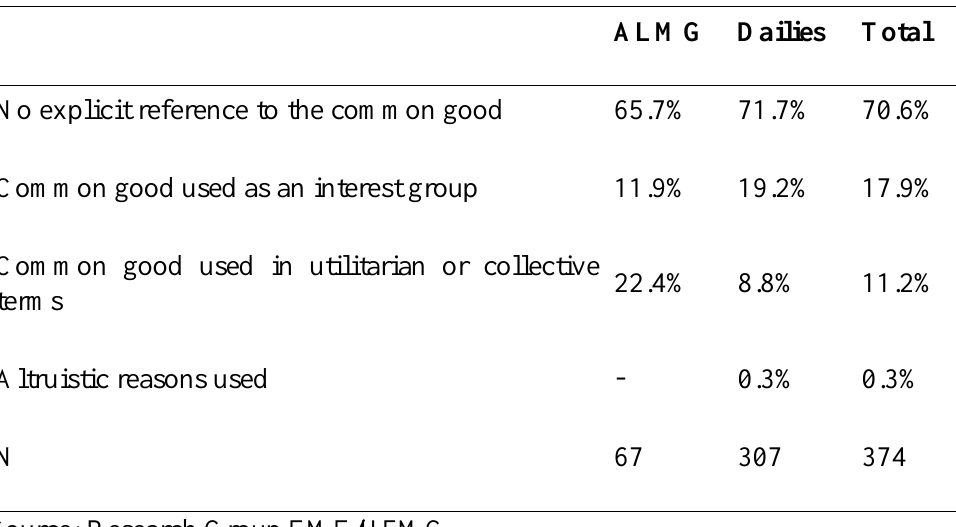
ALMG Dailies Total